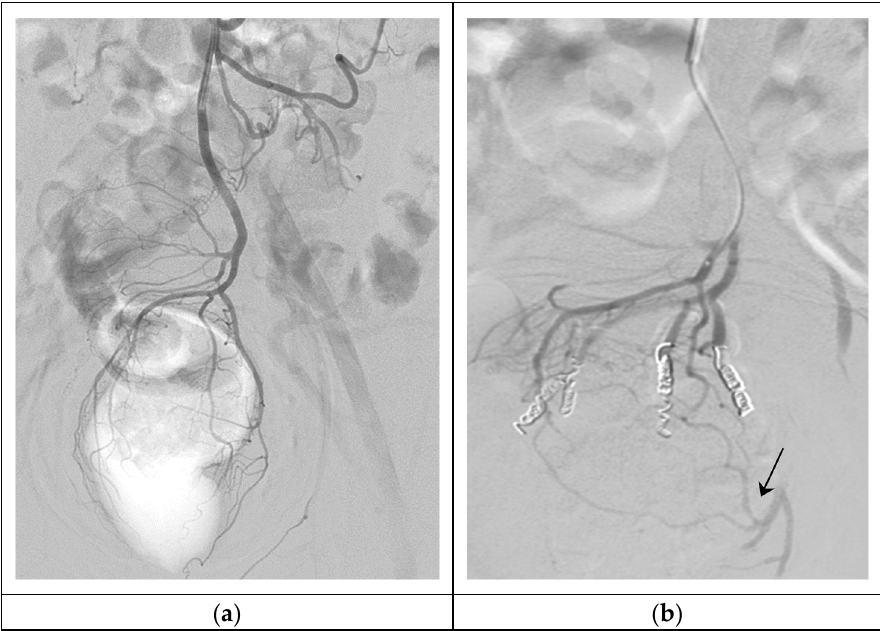
Figure 2. Hemorrhoidal embolization. ( a ) Arteriography of SRA, showing the vascular anatomy of the hemorrhoidal plexus (type I); ( b ) Super-selective embolization of four branches of the SRA with 300–500 µ m particles and 3 mm 5 cm coils, persistent MRA anastomoses in the left part of the hemorrhoidal plexus (arrow).